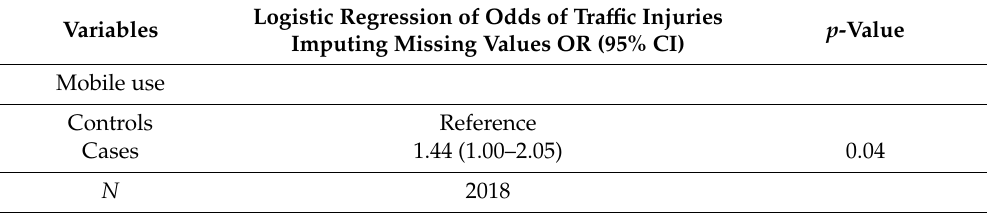
Table 4. Logistic regression analyses of the association between mobile use and tra ffi c